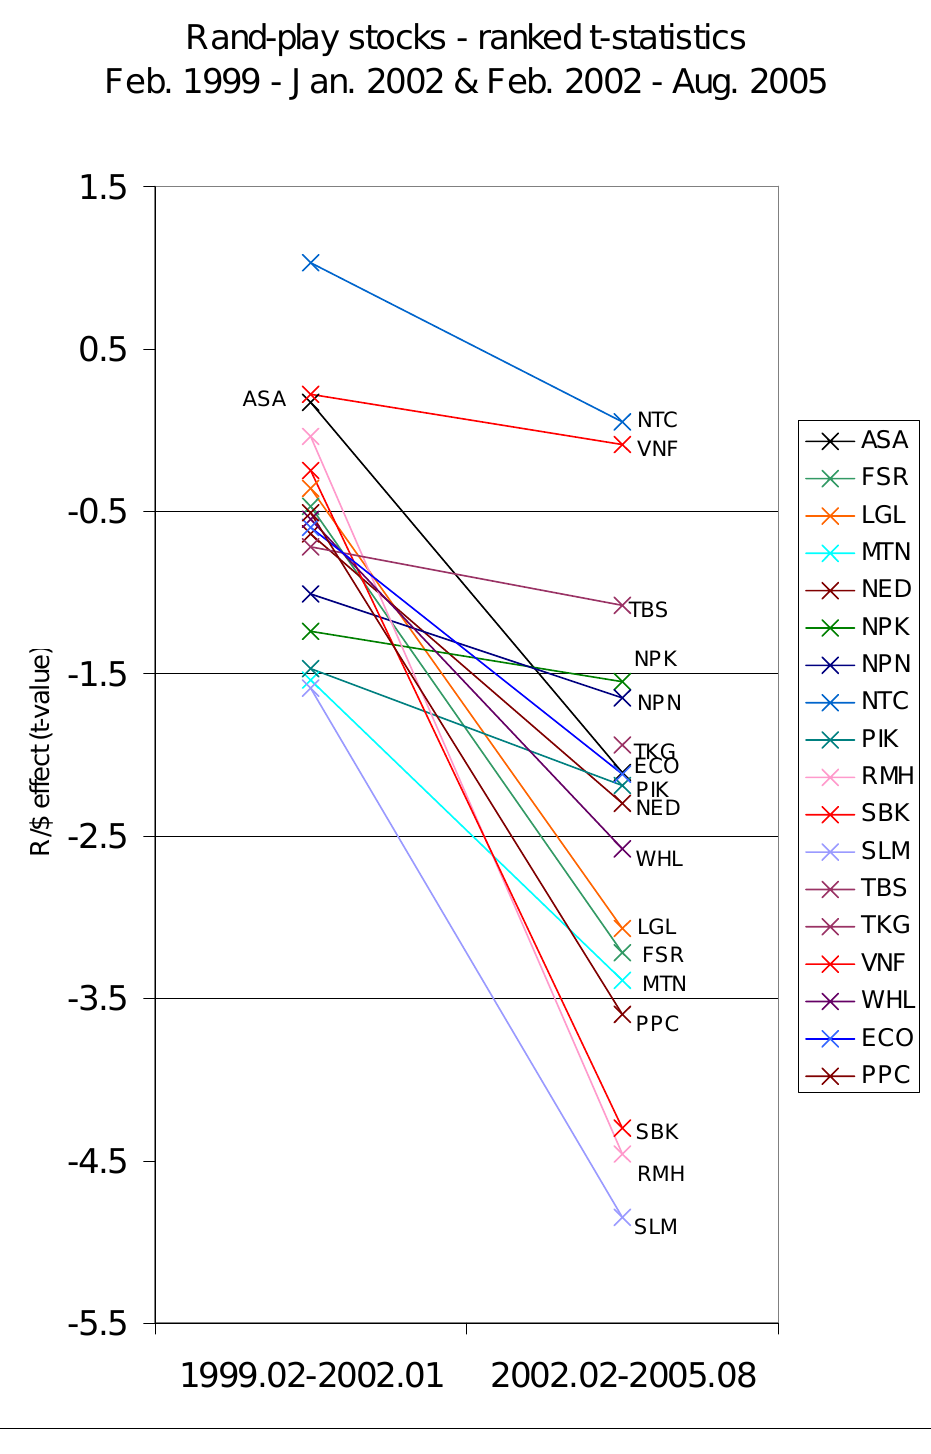
Figure 1: Rand-play stocks: Comparing the ranking of the Rand Exchange rate effect (t-statistic) over the periods February 1999 to January 2002 with February 2002 to August